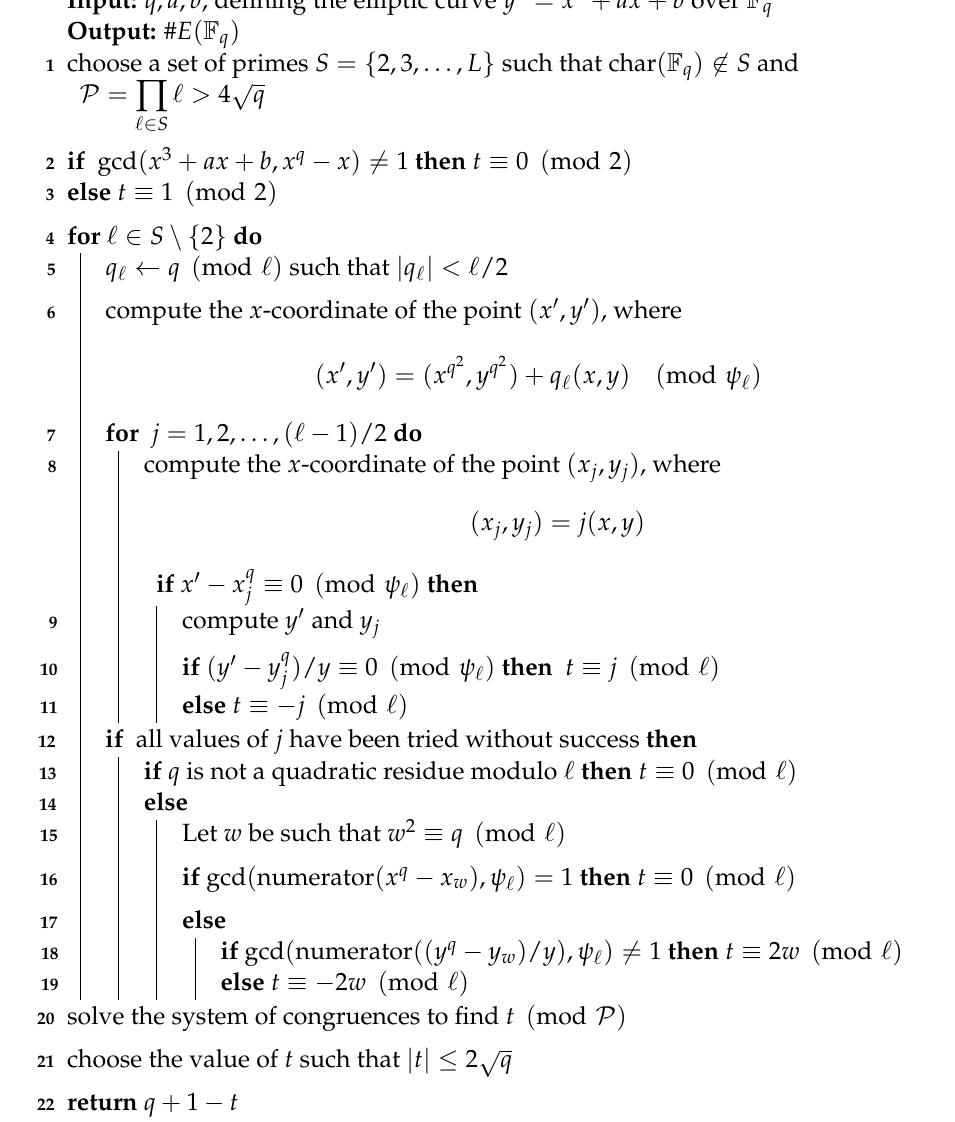
Algorithm A4: Schoof’s